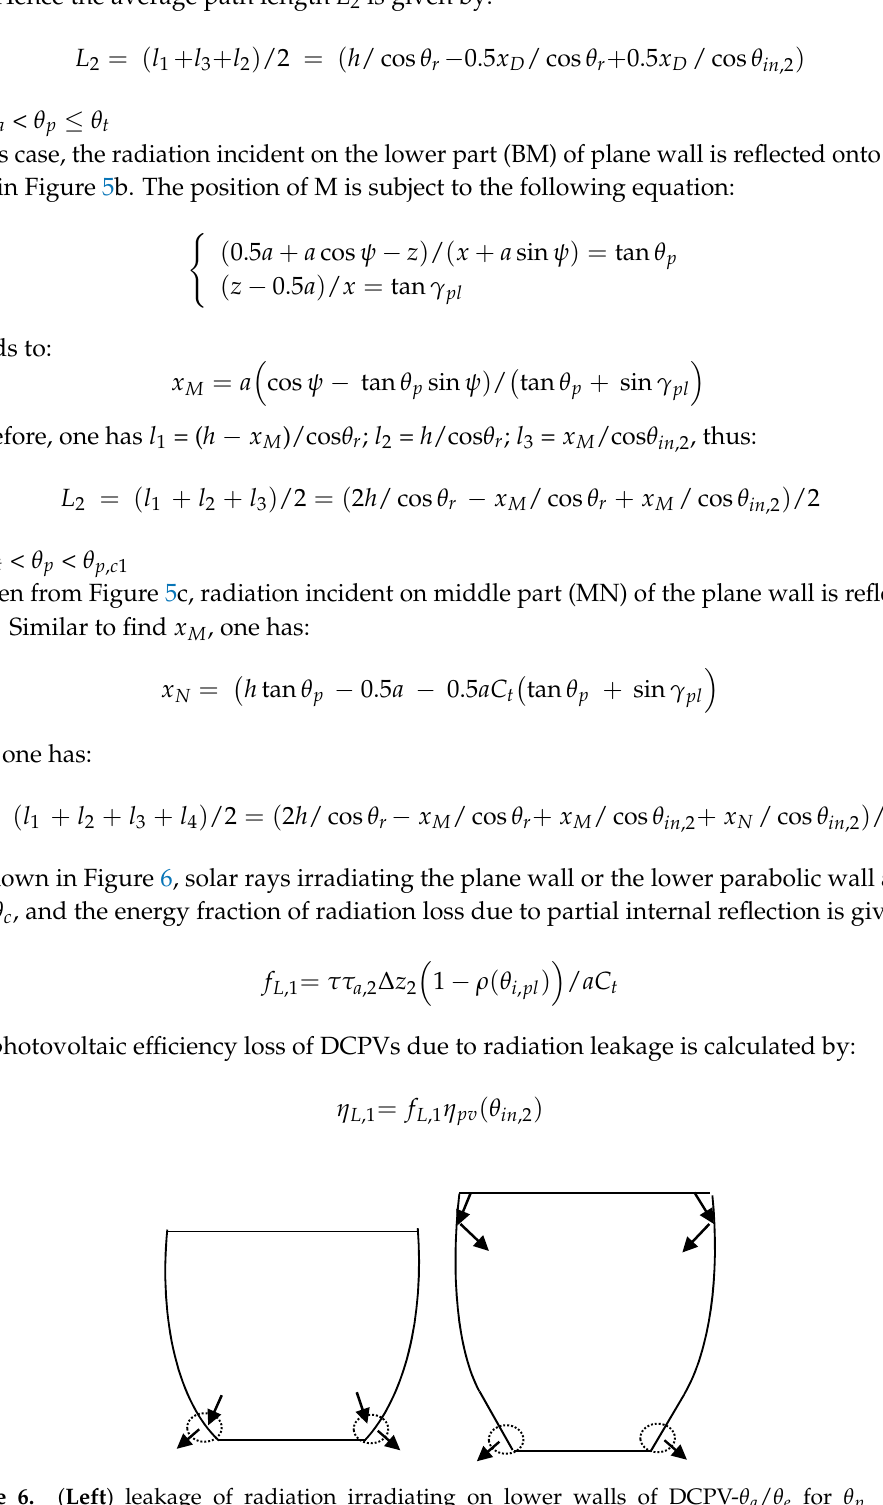
θ θ≤ θ / θ for ; ( Right ) p a a e θ θ> . p a